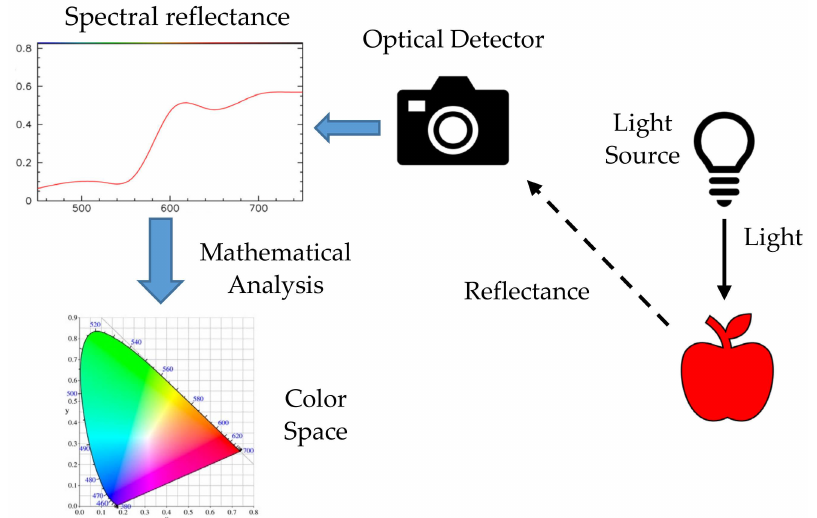
Figure 1. Color detection